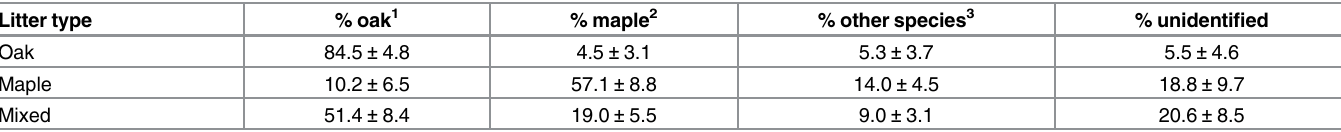
Table 1. The species composition by mass of litter collected in fall 2008 and re-distributed to common garden fuel beds. Litter